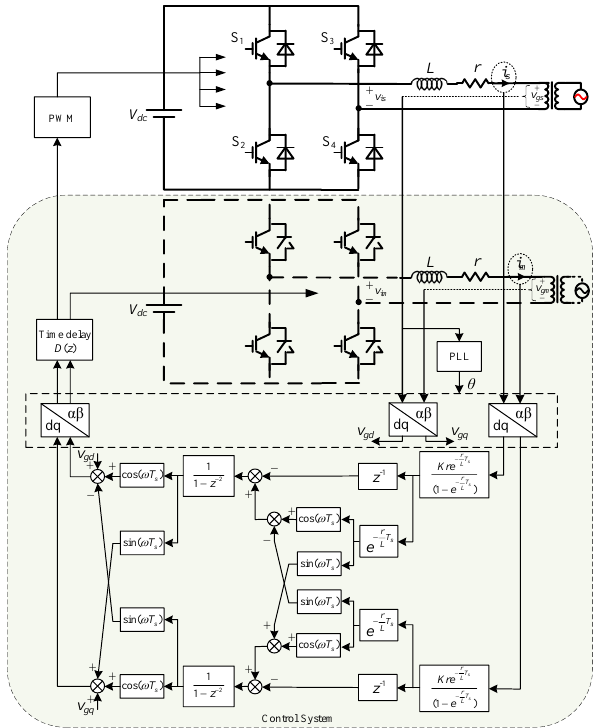
Figure 10. Block diagram of the grid-connected inverter with the proposed control strategy.